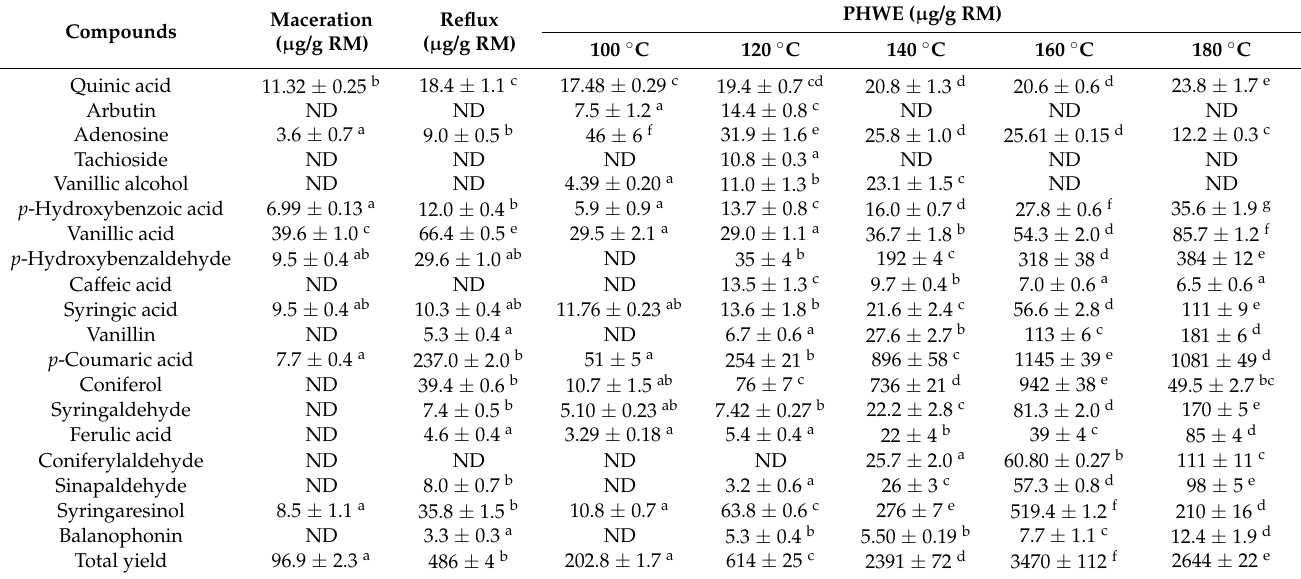
Table 2. Contents of target phenolic compounds in the extracts obtained from PHWE at different temperatures and from conventional